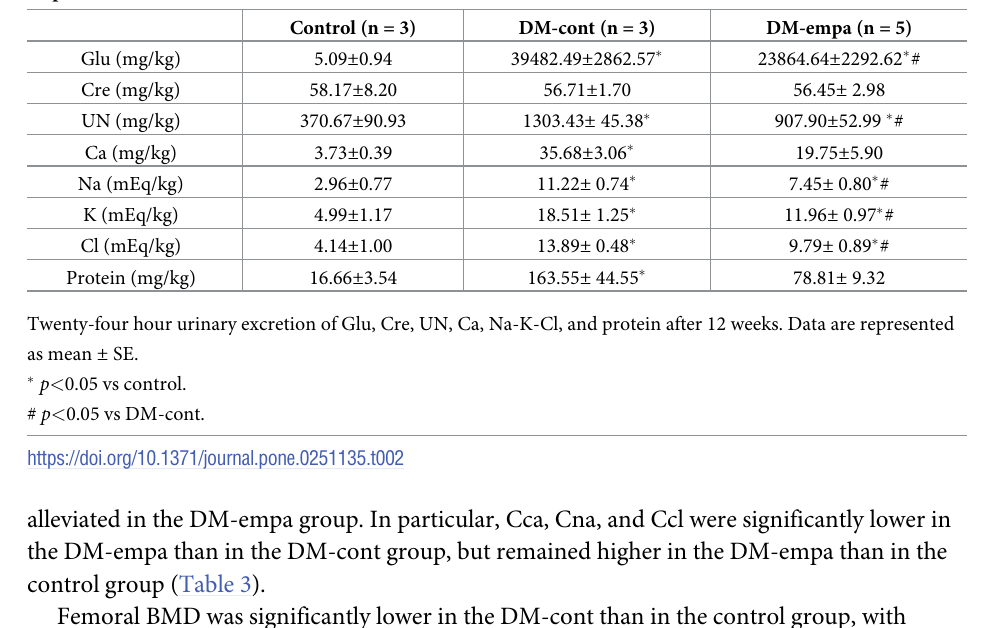
Table 2. Comparison of 24 hours-urinary excretion relative to body weight between control, DM-cont, and DM- empa.